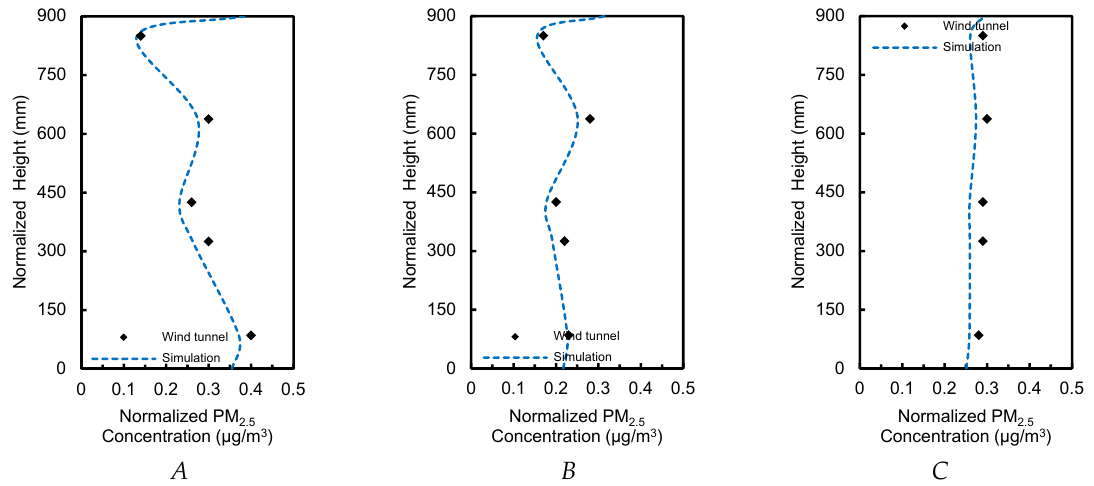
Figure 3. Comparison of normalized PM 2.5 concentrations in simulations and wind tunnel tests at points A , B and C . C = C x / C in , C x is the concentration at points A , B and C, respectively. C in is the concentration added at the inlet boundary.